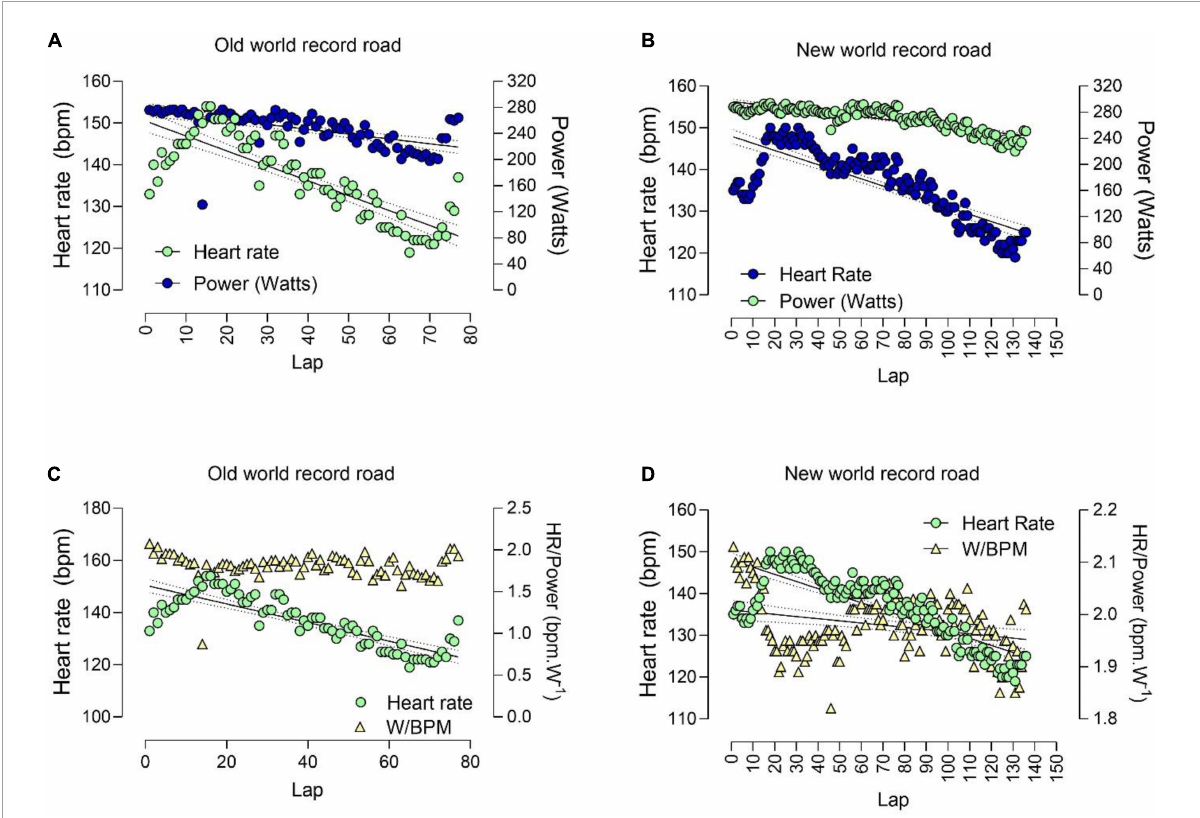
FIGURE3 Relationship between power, heart rate and ratio between power and heart rate, for laps over time. (A) Relationship between power (watts), heart rate (bpm) and laps in old world record; (B) relationship between power (watts), heart rate (bpm) and laps in new world record; (C) heart rate (bpm) and ratio between power and heart rate (W/bmp) in old world record; (D) heart rate (bpm) and ratio between power and heart rate (W/bmp) in new world